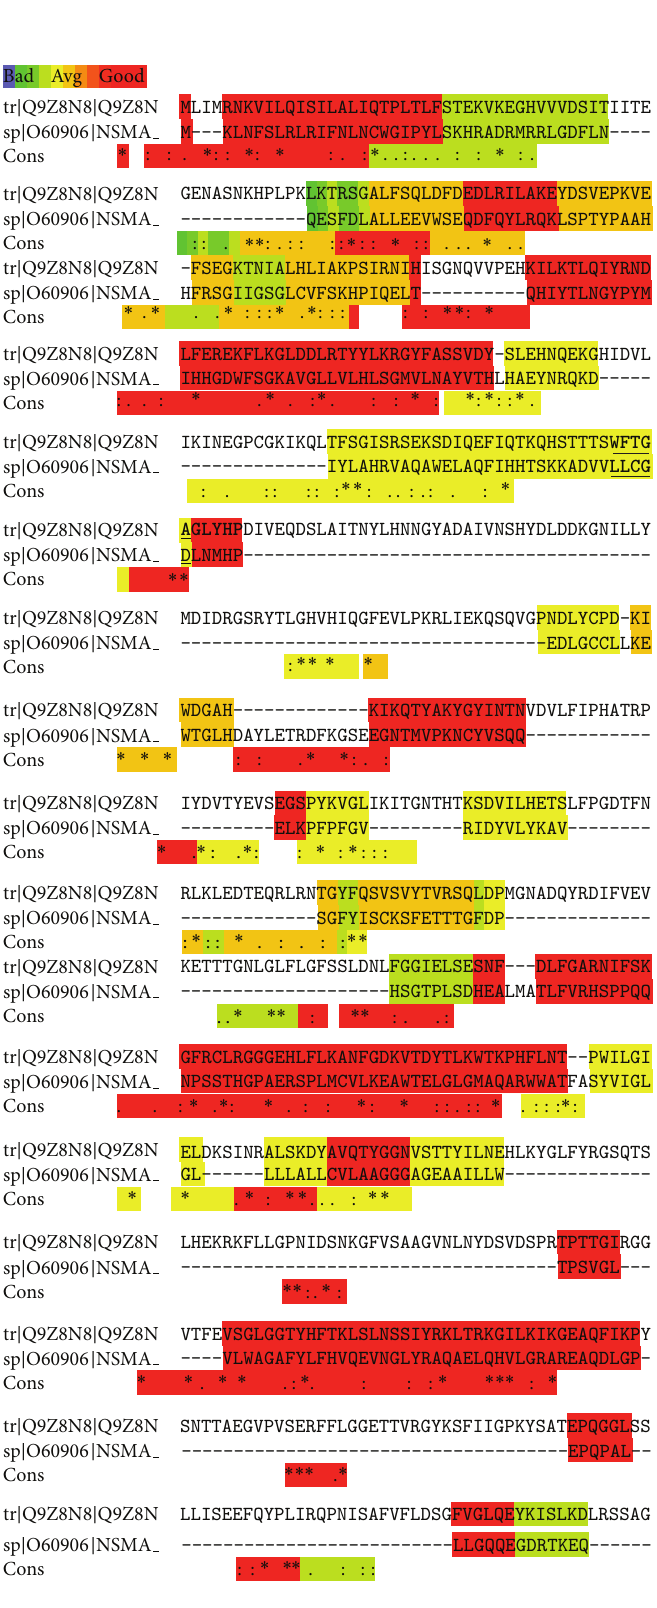
Figure 1: T-coffee alignment of the sequences of tr | Q9Z8N8 | Q9Z8N of Chlamydia pneumoniae (CPn0300) and human neutral sphingomyelinase, NSMase sp | O60906 | NSMA. Putative proton binding site and proton acceptor site are underlined (residues 220 to 229 and 463 to 465 in CPn0300,